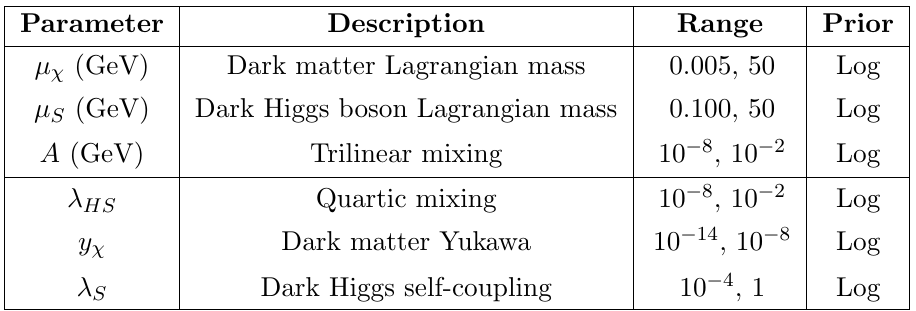
Figure 7. Examples of yields evolution when the (cid:31) production is dominated by the late time decay of S . (a) Dependence on the trilinear coupling A , which (for (cid:12)xed (cid:21) of S decay to (cid:31) and to SM particles. Here the freeze-out of S proceeds as for usual WIMP, with decoupling at x 20. (b) Dependence on the portal coupling (cid:21) (cid:24) leads to smaller mass, due to the EWSB contribution, and also earlier freeze-out with larger Y which then translates to larger (cid:31) population. Note that in this plot the relation between x and time/temperature is di(cid:11)erent for di(cid:11)erent lines.